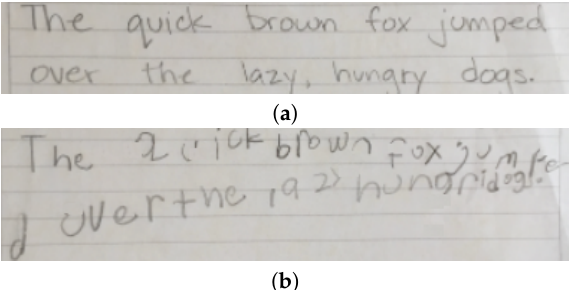
Figure 1. Handwriting samples of a normal and a dysgraphia patient. ( a ) Normal handwriting. ( b ) Dysgraphia patient’s